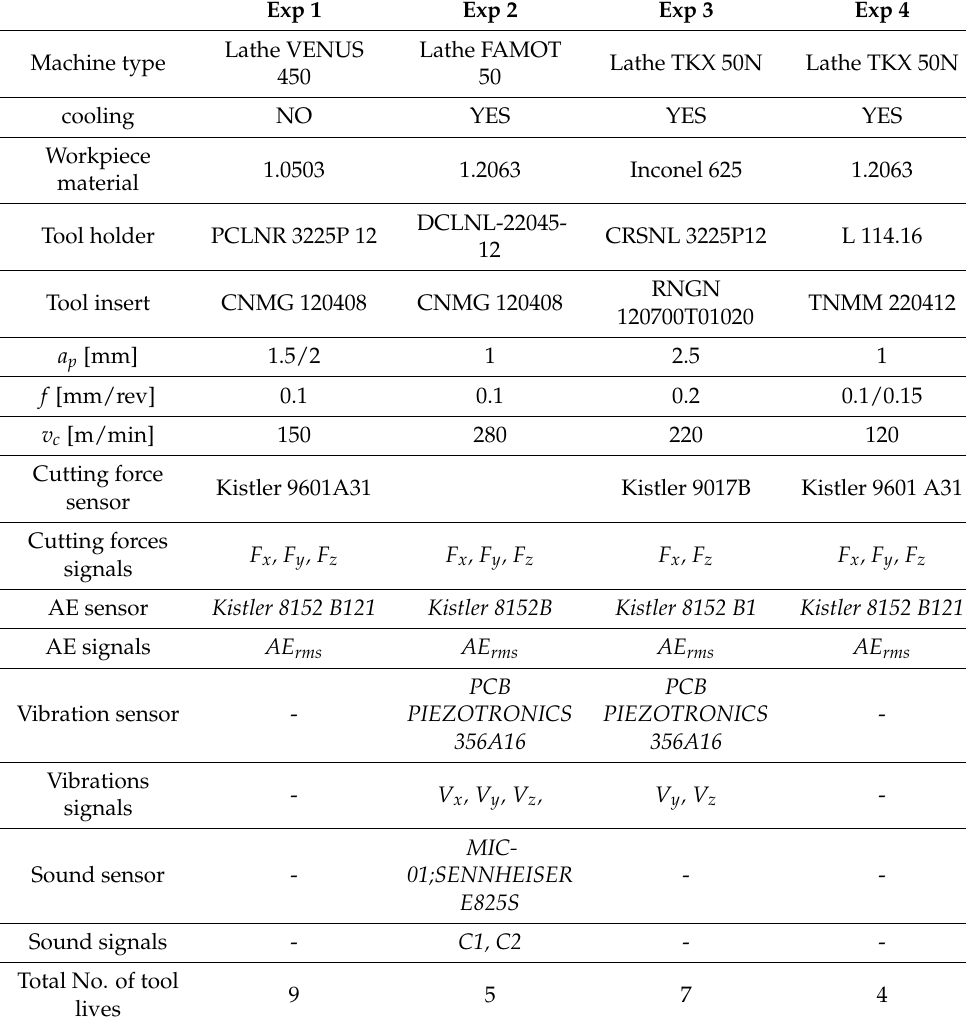
Table 1. Cutting conditions of